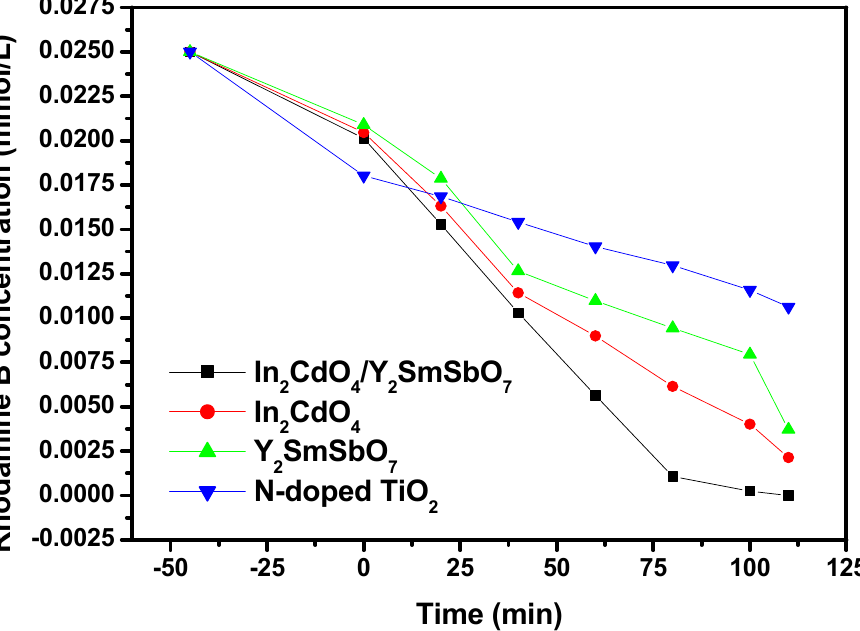
Figure 14. Concentration change curves of rhodamine B during PCD of rhodamine B with In 2 CdO 4 /Y 2 SmSbO 7 nanocomposite, In 2 CdO 4 , Y 2 SmSbO 7 , or N-TO as the photocatalyzer under visible light irradiation.